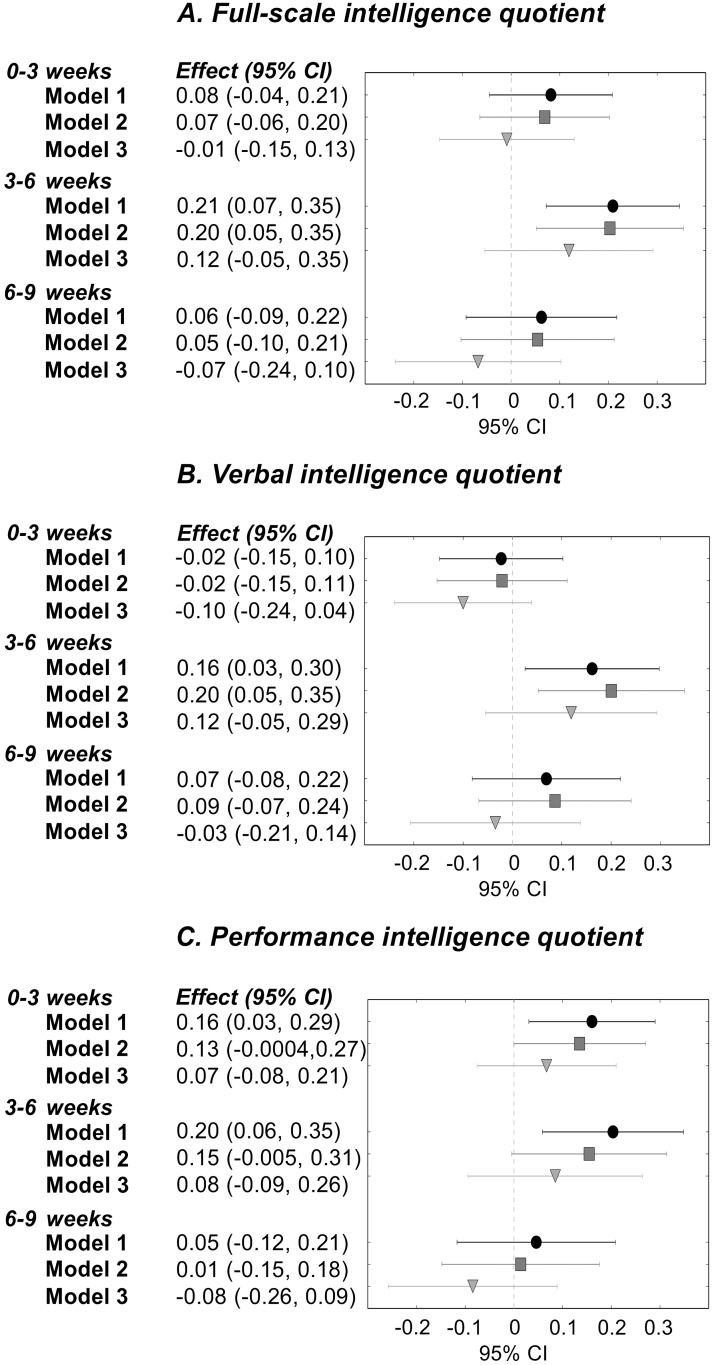
Total energy intake from birth to 3 weeks, 3 to 6 weeks, and 6 to 9 weeks of age, and full-scale, verbal and performance intelligence quotient in young adulthood, among individuals born with very low birth weight (<1500 grams).aModel I: adjusted for gestational age, sex, birth weight standard deviation score, and age at follow-up. Model II: adjusted for Model I factors, parental education, maternal smoking during pregnancy, and preeclampsia. Model III: adjusted for Model I factors and neonatal complications, including septicemia, bronchopulmonary dysplasia, patent ductus arteriosus, blood exchange transfusion, duration of ventilator treatment, and intraventricular hemorrhage. a The number of participants in each analysis varied according to data availability. At 0–3 weeks, 86 participants; at 3–6 weeks, 82 participants; and at 6–9 weeks, 79 participants had data available on total energy intake and were included in the analyses (Model 1–2). In Model 3, we had to further exclude two people because of missing data on neonatal complications. Abbreviations: CI: confidence interval; Effect: change in full-scale, verbal, and performance intelligence quotient scores, in SD units, for each 10kcal/kg/day increase in total energy intake.